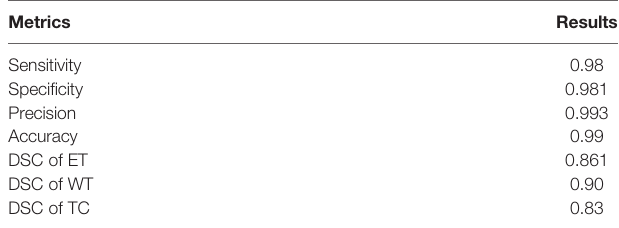
TABLE 2 | Quantitative results of the proposed model.